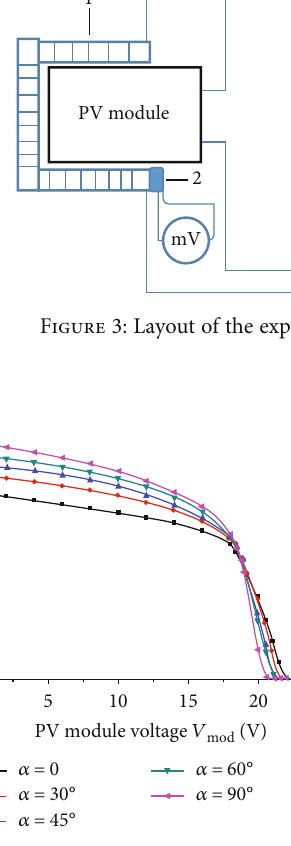
Figure 4: Current-voltage characteristic curves vs. inclination angle α ; E = 630 W.m -2 and B = 15 mT.